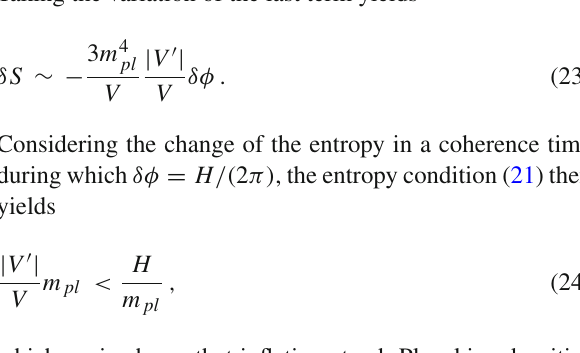
where ξ( N ) is a Gaussian random variable with mean zero and unit variance,